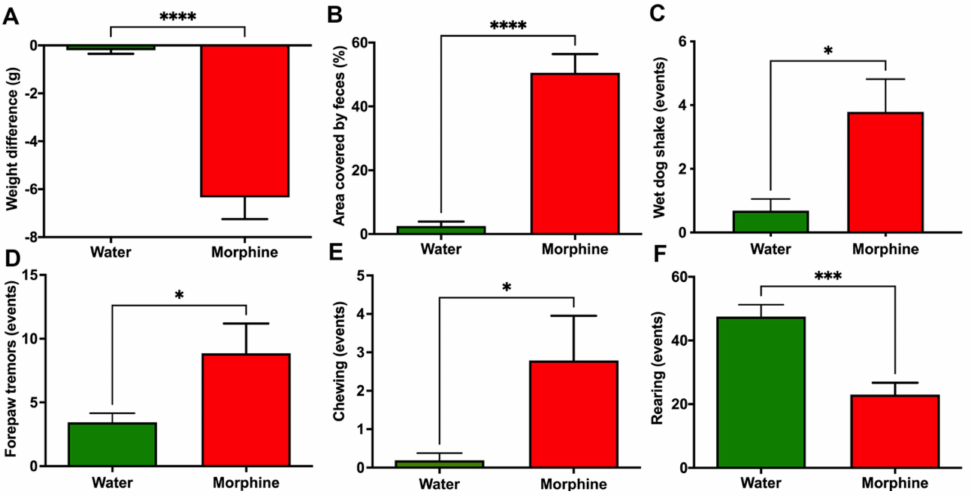
Figure 5. A clear opioid deprivation syndrome is induced by naloxone administration in Wistar rats that had voluntarily consumed morphine. ( A ) Weight loss, ( B ) Area covered by feces (%), ( C ) Wet-dog shake events, ( D ) Forepaw tremors, ( E ) Chewing, and ( F ) Rearing events. Rats that had voluntarily ingested a morphine solution (15–18 mg/kg/day) for four weeks were intraperitoneally injected with 5 mg/kg of the opioid receptor antagonist naloxone. Animals drinking only water were used as controls. Data were recorded for 30 min after naloxone administration and expressed as mean ± SEM. n = 8 in each experimental group. * p < 0.05; *** p < 0.001; **** p < 0.0001, Two-tailed Student t